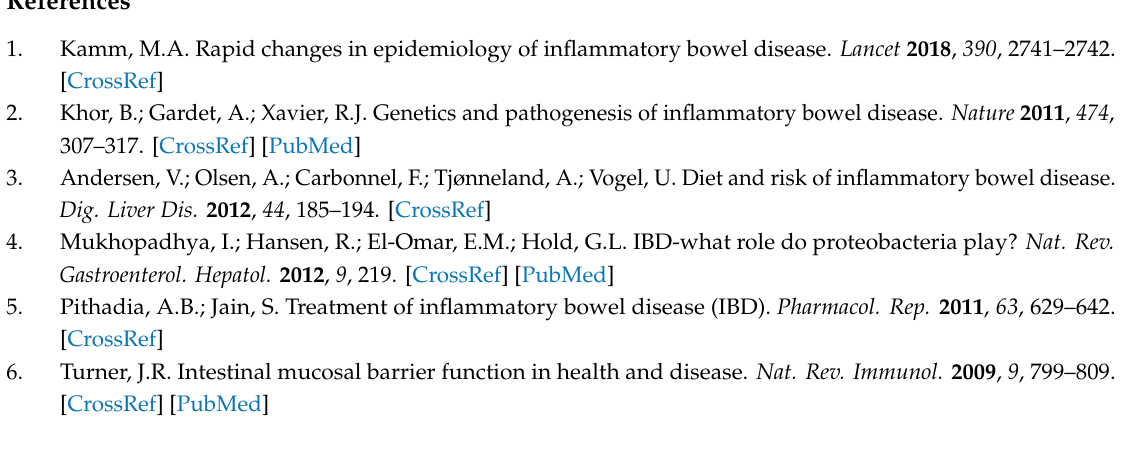
Figure S1: E ff ects of L. brevis Bmb6 on the localization of TJ proteins ( a ) ZO-1 and ( b ) claudin-1, in the colon of DSS-induced colitis